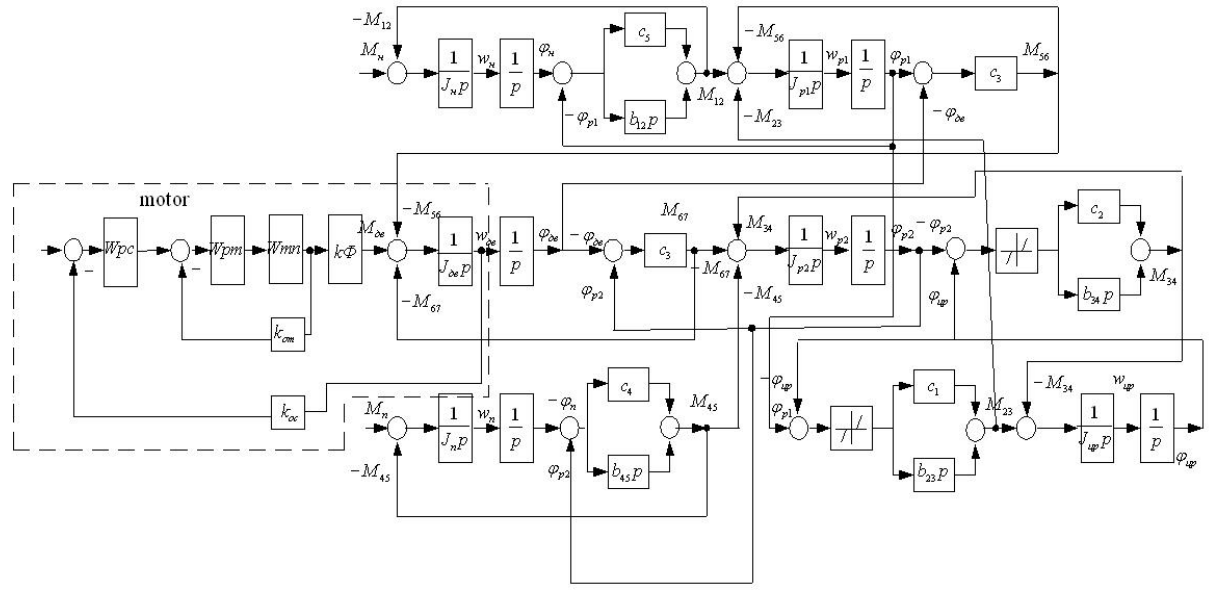
Figure 4. The structural diagram of the filled looper